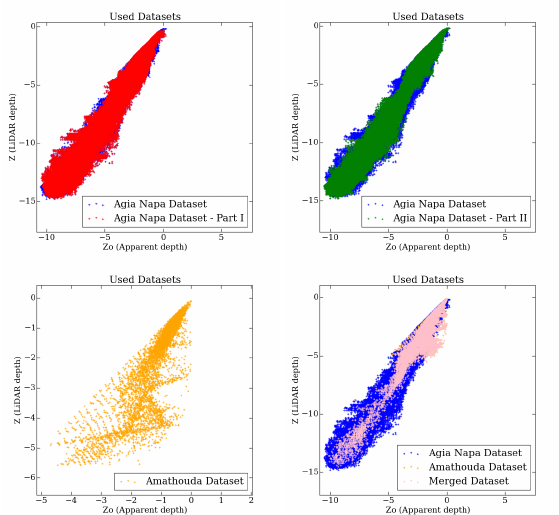
Figure 5. The Z - Z o distribution of the used datasets: the Agia Napa Part I dataset over the full Agia Napa dataset (top left), The Agia Napa Part II dataset over the full Agia Napa dataset (top right), Amathouda dataset (bottom left), The merged dataset over the Agia Napa and Amathouda datasets (bottom right).